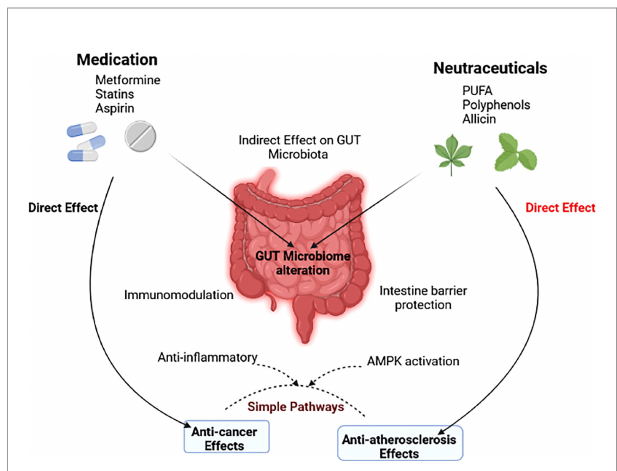
FIGURE 5 | The gut microbiota ’ s indirect role in modulating the effects of drugs and nutraceuticals is depicted in a diagram (Wu et al.,